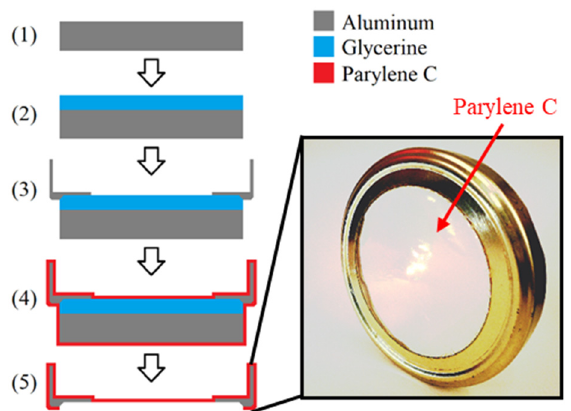
Figure 1. Fabrication process of large free-standing Parylene C membranes for the investigation of the barrier properties, the optical properties, and the chemical bondings.